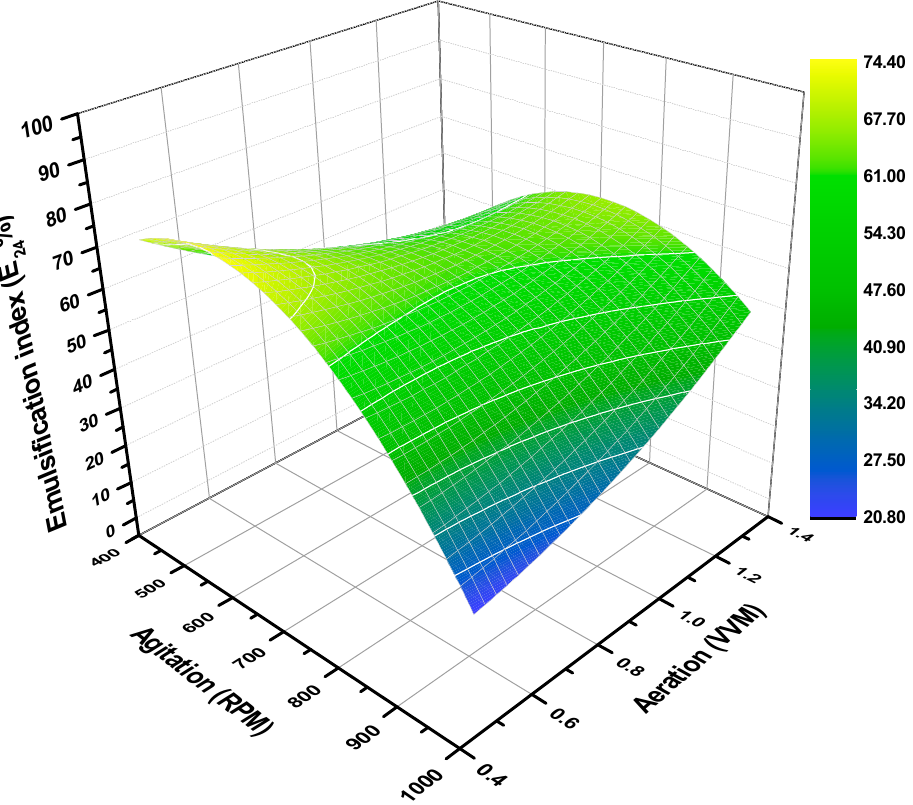
Figure 2. Theoretical values of the emulsification index (E 24 %) were calculated by the quadratic model in response to surface methodology from experimental values of lipopeptide production.